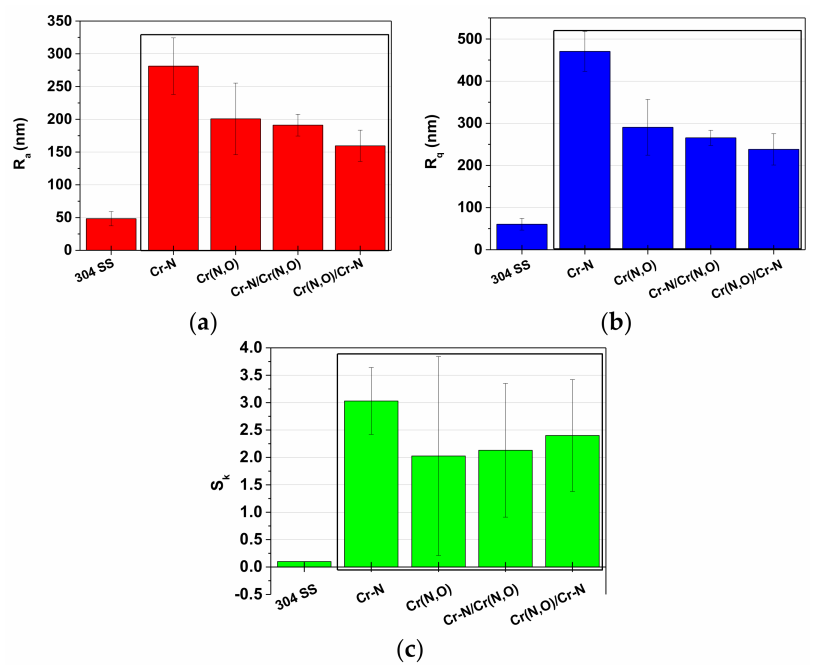
Figure 4. The roughness of Cr-based coatings before the corrosion test: ( a ) R a parameter; ( b ) R q parameter; ( c ) S k